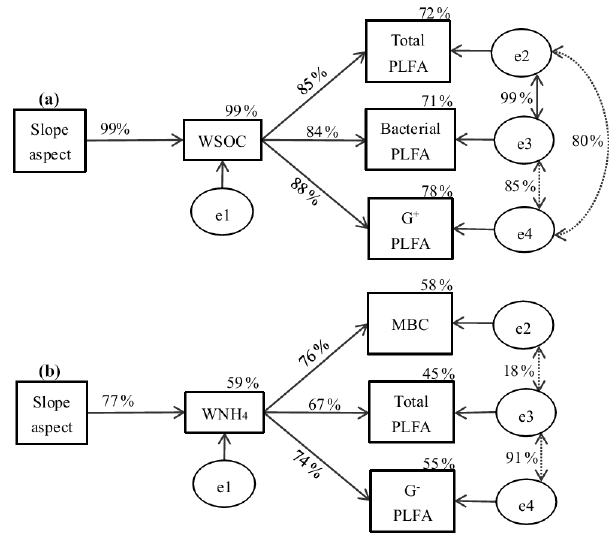
Figure 5. Structural equation models of the effect of slope as- pect on microbial properties in the rhizospheric (a) and non- rhizospheric (b) soils. Numbers beside the arrows are standardized path coefficients (equivalent to correlation coefficients). Solid lines indicate significant standardized path coefficients ( P < 0 . 05). Cir- cles indicate error terms (e1–e4). Percentages near the endogenous variables indicate the variance explained by the